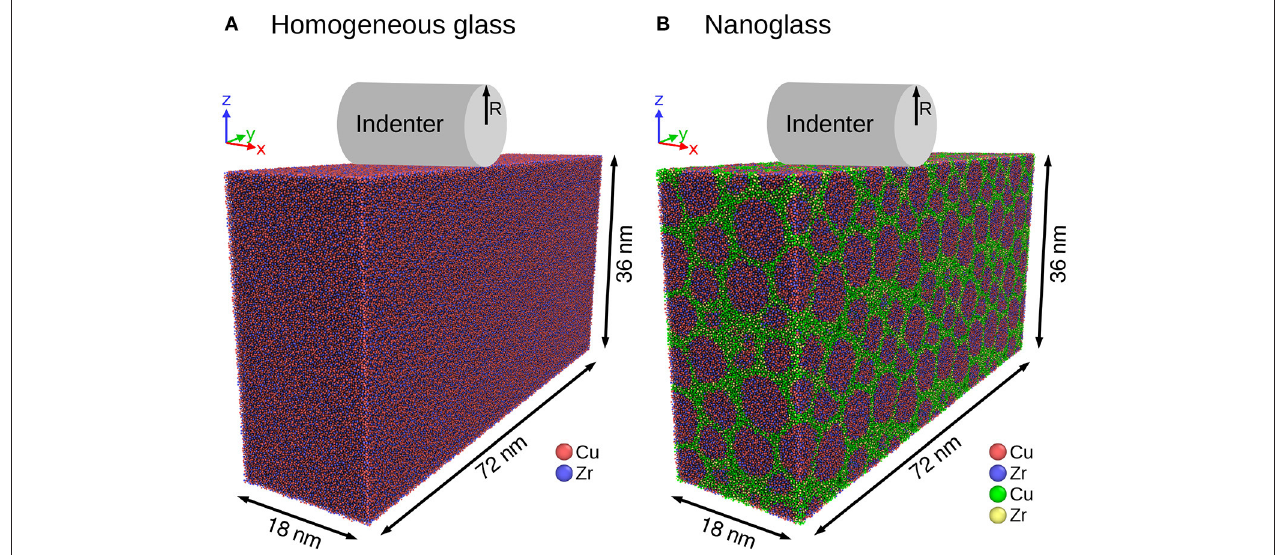
FIGURE 1 | Nanoindentation simulation models for (A) homogeneous glass and (B) nanoglass. The radius of the virtual cylindrical indenter, R, is 20nm. Homogeneous glass is compositionally homogeneous, while nanoglass is compositionally heterogeneous. Color scheme is indicating regions with deviation in composition. The average grain size of the nanoglass is about